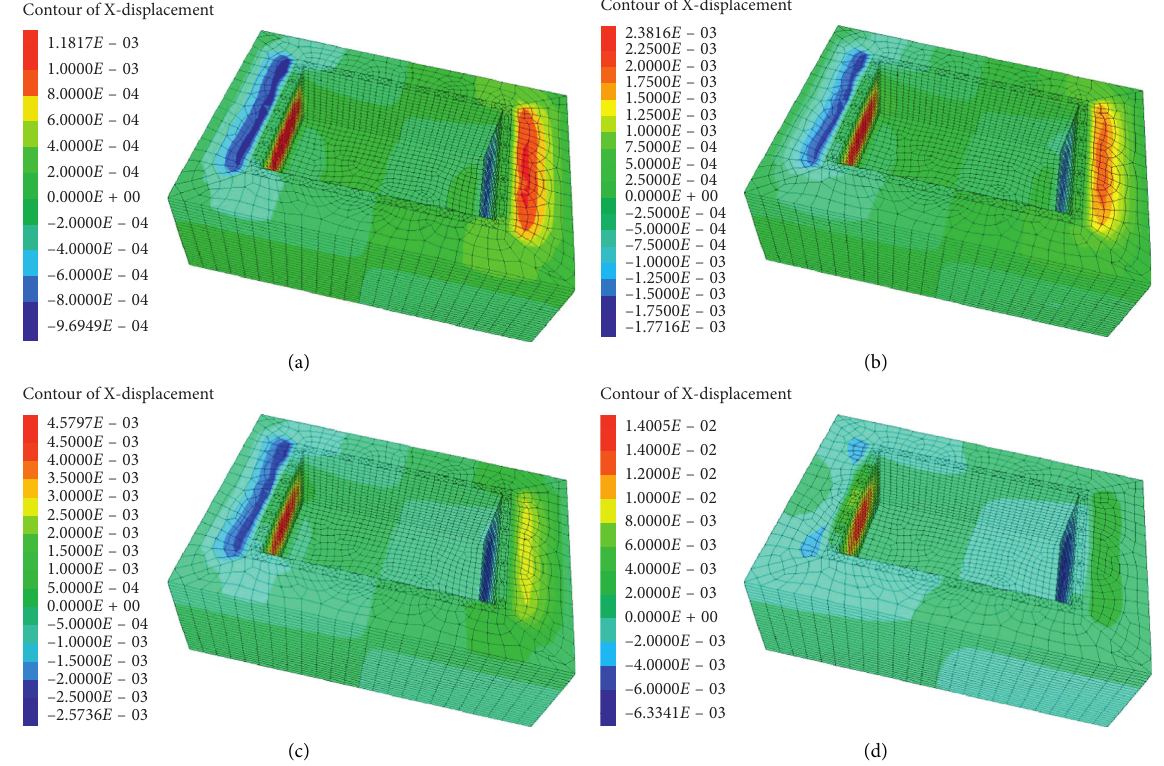
Figure 13: Horizontal displacement nephogram of the side wall of the foundation pit at each loading stage. (a) 10kPa, (b) 20kPa, (c) 30kPa, and (d) 40kPa.